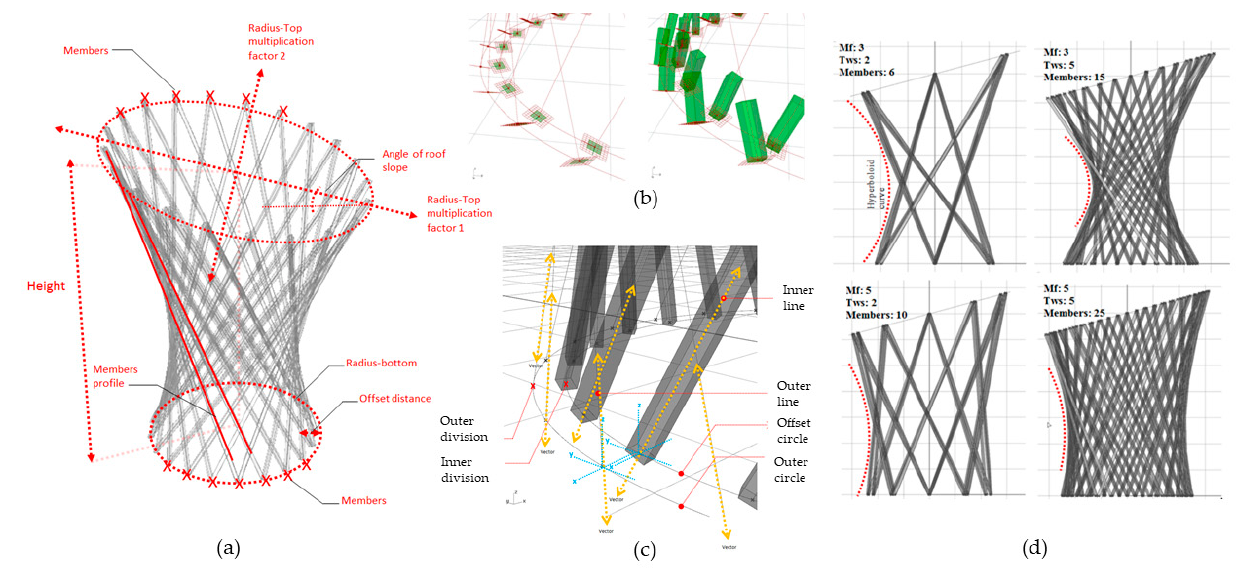
Figure 7. Modeling logic of the hyperboloid wooden structure: ( a ) the set of dynamic parameters; ( b ) plan vector profiling; ( c ) illustration of random angle; ( d ) random examples of the structure with certain parameter combination.